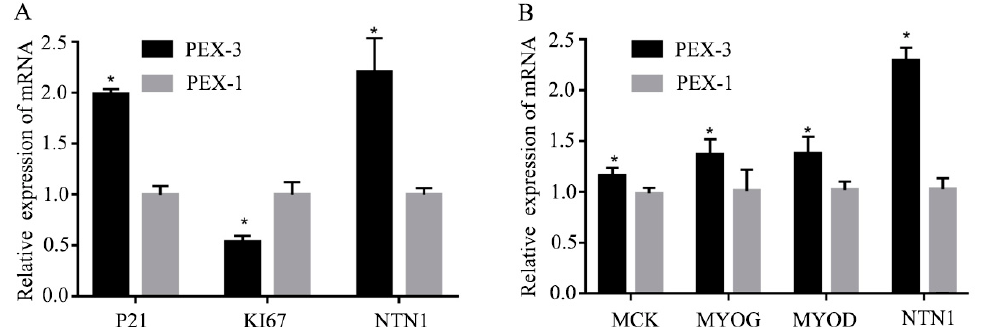
Figure 3. Effect of over-expression of NTN1 on the proliferation and differentiation of C2C12 cells. ( A ) Expression of NTN1 , KI67 , and P21 gene in C2C12 cell proliferation phase. ( B ) Expression of MCK, MYOG, MYOD , and NTN1 gene in C2C12 cell differentiation phase. The results were represented as mean ± SD. The expression level of genes in NTN1 over-expression C2C12 cells was determined by q-PCR using NC as the control. PEX-3 and PEX-1 were the over-expression plasmid, and the negative control, respectively. * p < 0.05.